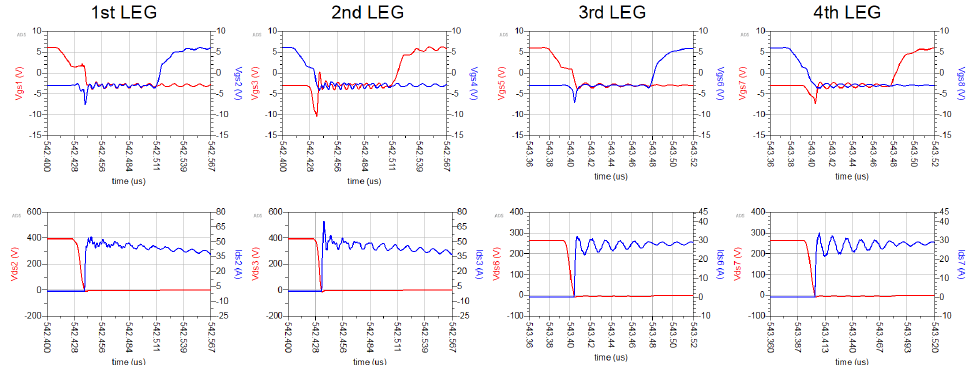
Figure 12. ZVS turn-ON condition is met for every transistor in the worst-case scenario of point